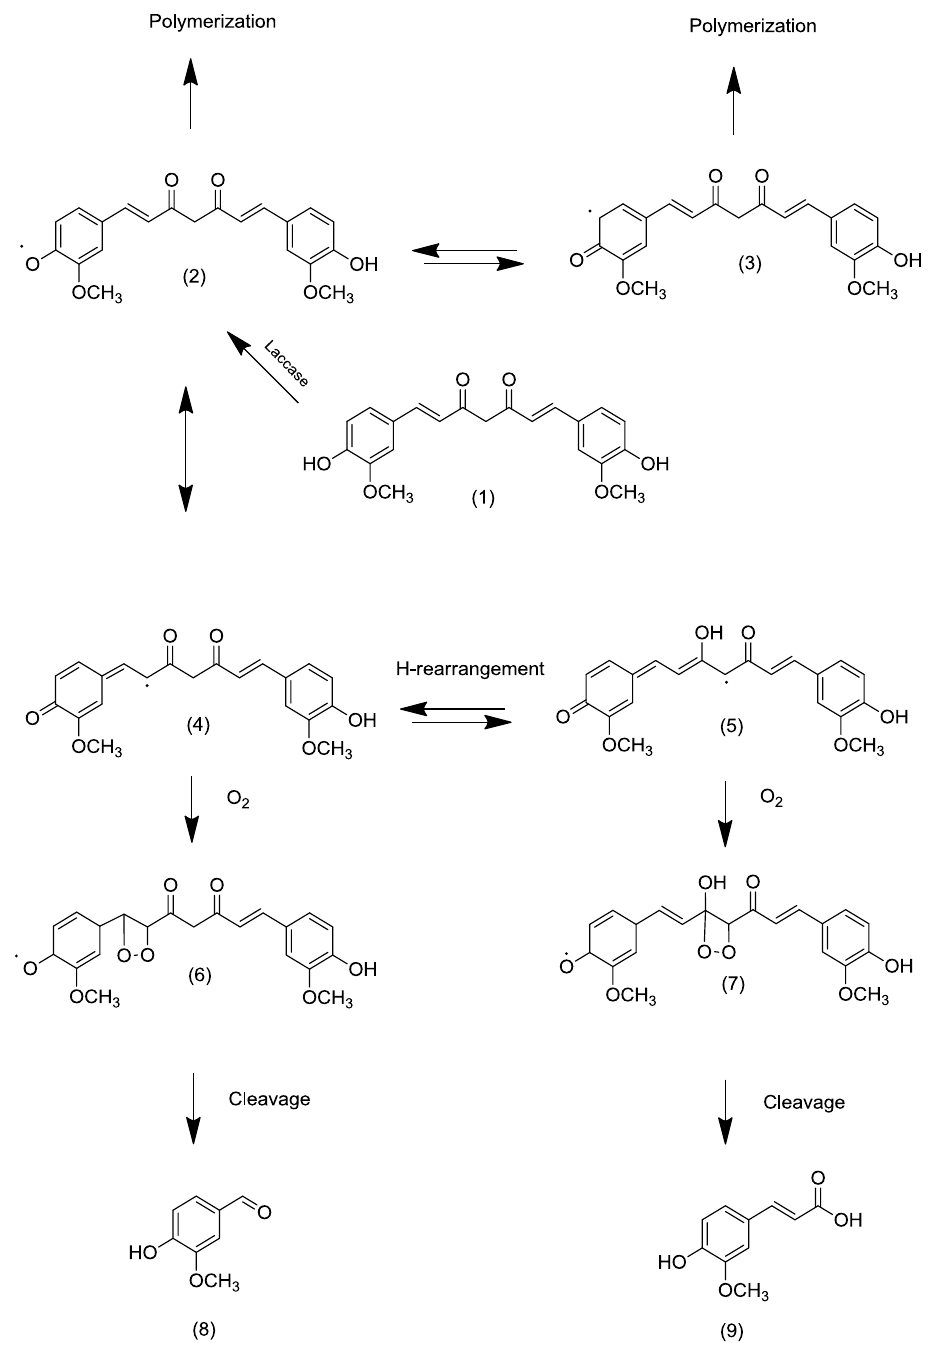
Figure 1. Hypothetical pathway of laccase-catalyzed biotransformation of curcumin. (1) Curcumin; (2) O-centered curcumin radical; (3) C-centered curcumin radical; (4,5) C-centered radicals in the alkenyl chain of curcumin; (6,7) intermediate 1,2-endoperoxides of the curcumin radical; (8) Vanillin; (9) Ferulic